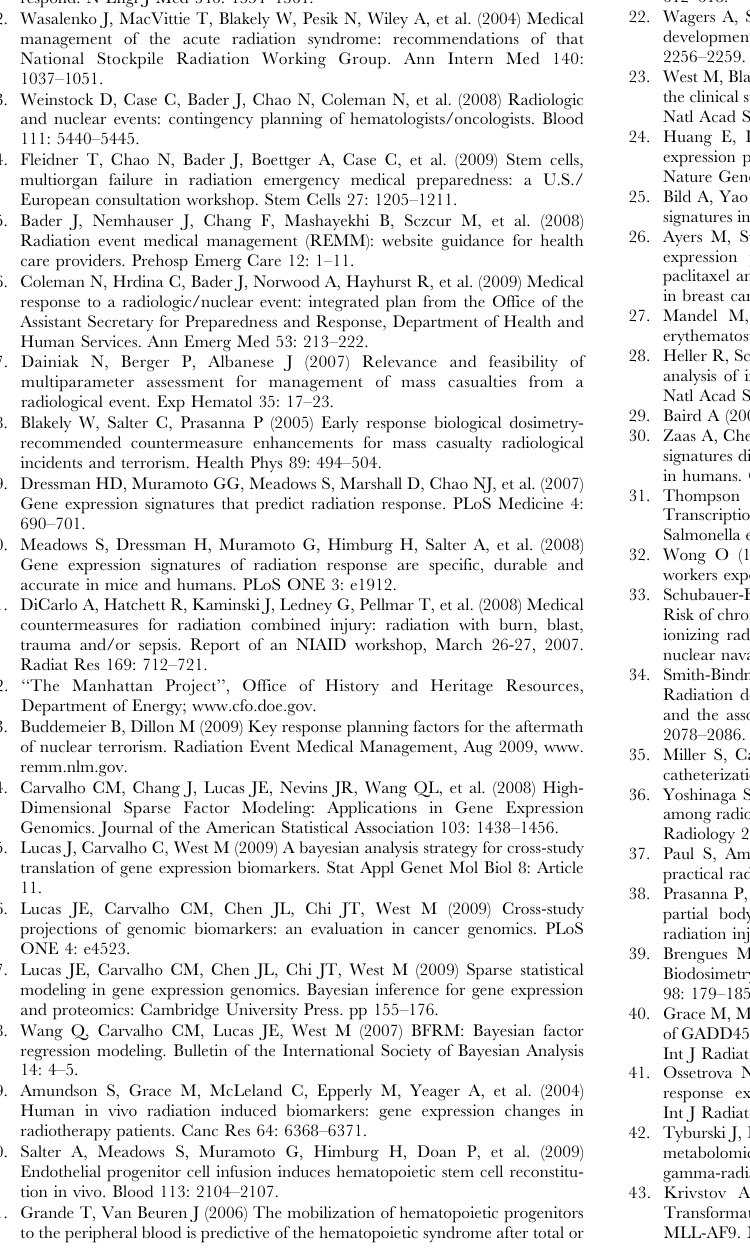
Table S2 Overlapping genes between partial irradiation conditions.